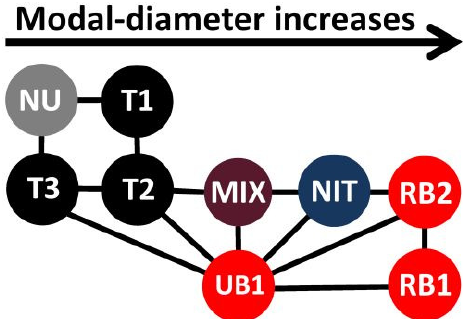
Fig. 3. Cluster proximity diagram during SAPUSS. In black are Traffic-related clusters (T1, T2, T3); in red background clusters (UB1, RB1, RB2); and in grey, purple and blue the special cases (NU, MIX and